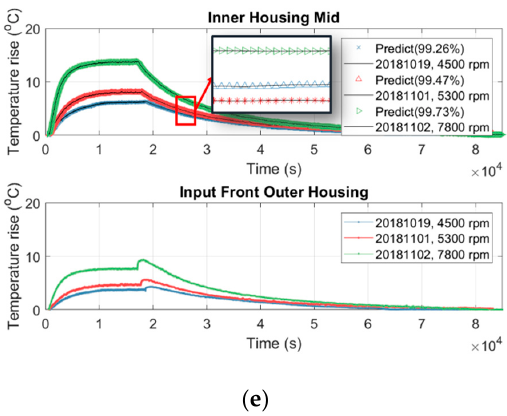
Figure 21. Using the 1I5O thermal-feature model (Table 6) to predict the internal temperature of the spindle at: ( a ) rear bearing A; ( b ) rear bearing B; ( c ) front bearing C; ( d ) front bearing D; ( e ) inner housing mid.